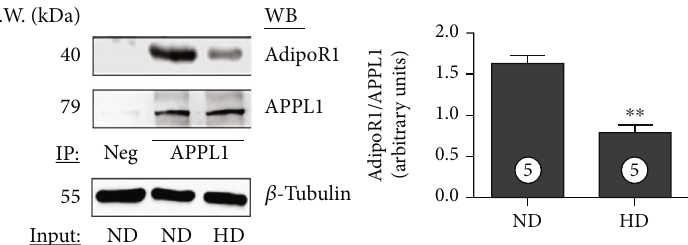
Figure 1: Interaction of AdipoR1 and APPL1 was blunted in HD induced type-2 diabetic heart in mice. (a) Coimmunoprecipitation. The interaction of AdipoR1 and APPL1 was detected in ND or HD mice. ∗∗ P < 0 : 01 vs. ND mice.